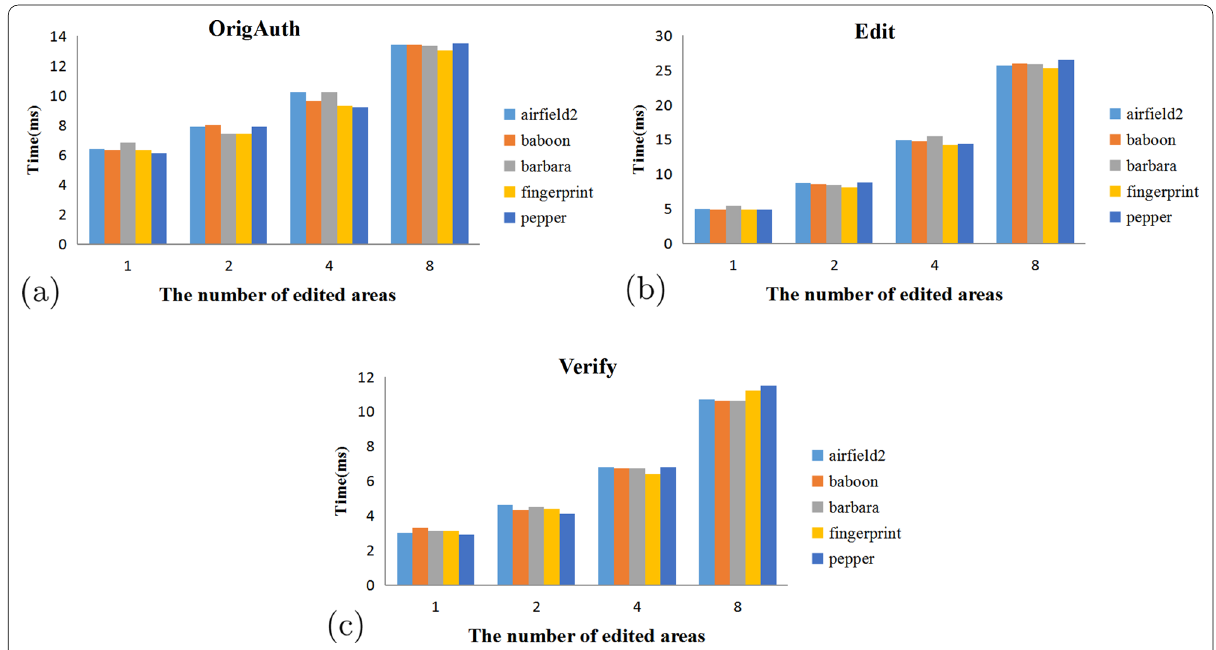
Fig. 6 Evaluation of our scheme computation